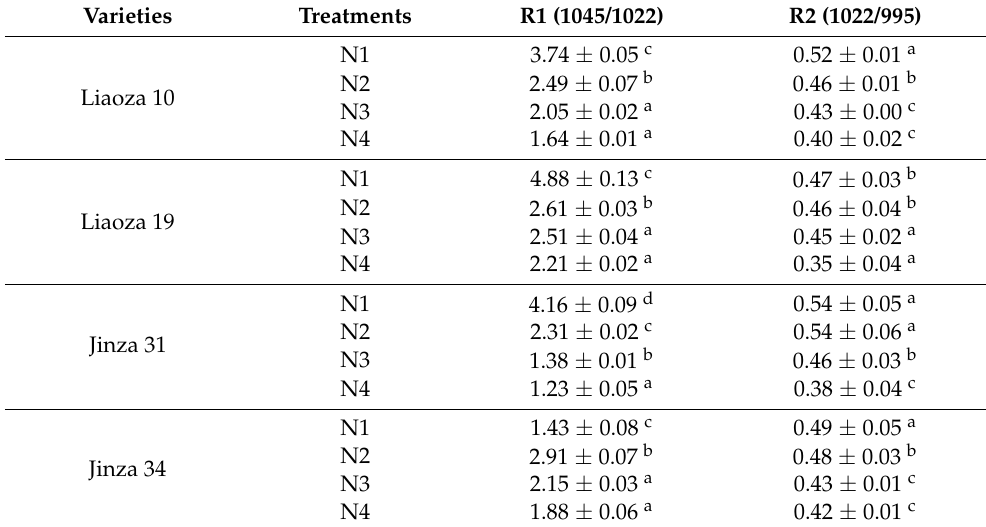
Figure 7. Effects of different nitrogen fertilizer level on short-range ordered structure of sorghum starch. Blue circle: 1045 cm − 1 ; red circle: 995 cm − 1 . Table 2. Effects of different nitrogen fertilizer level on short-range ordered structure of sorghum starch.